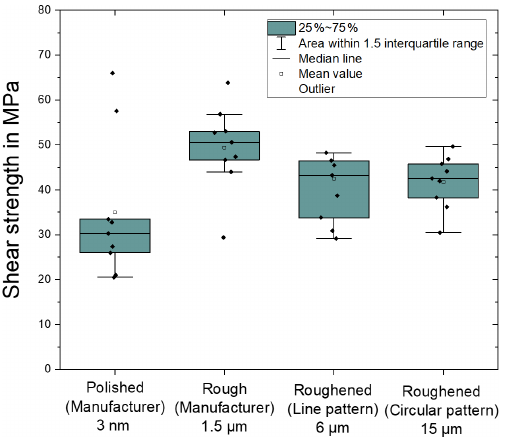
Figure 17. Shear strength of glass-soldered Al 2 O 3 chips under pressure. Glass solder G018-385 and sample size n = 9 per pres- sure.